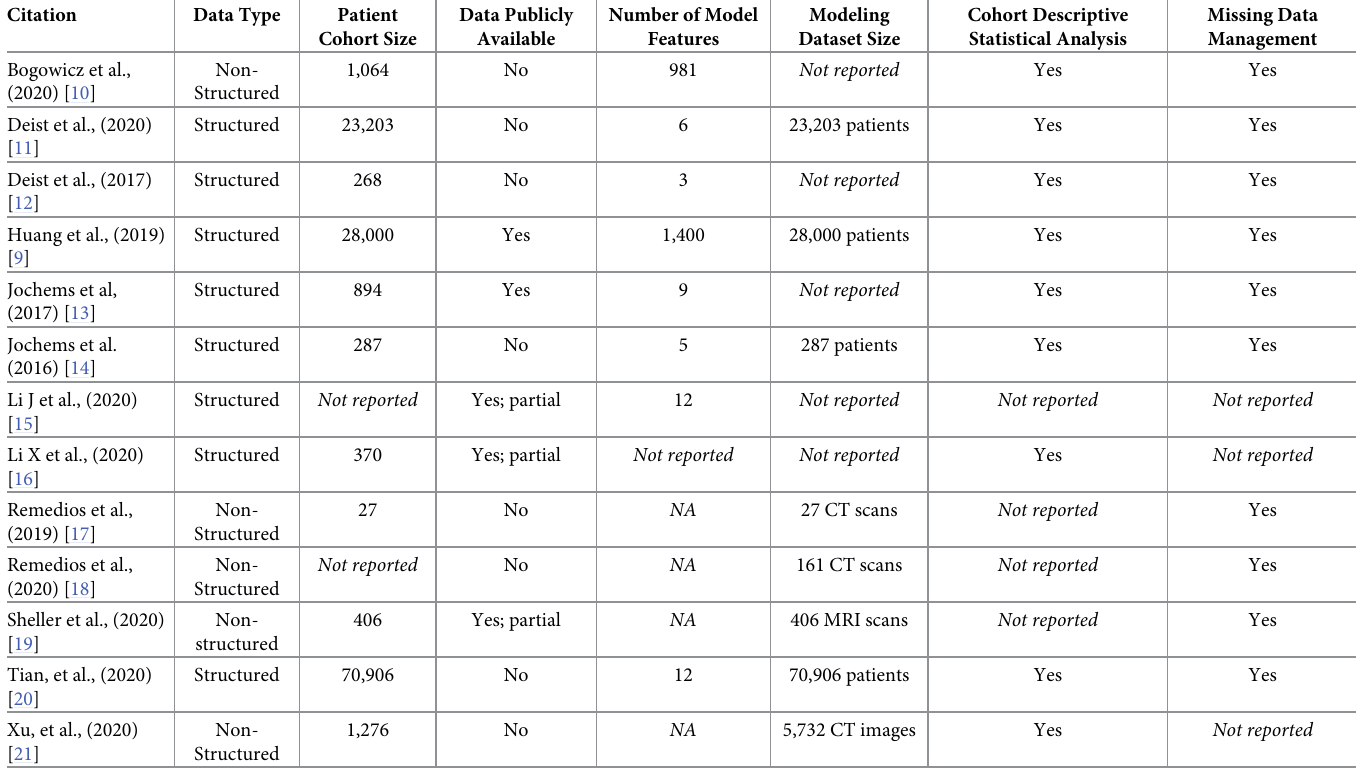
Table 2. Data composition and characteristics of included